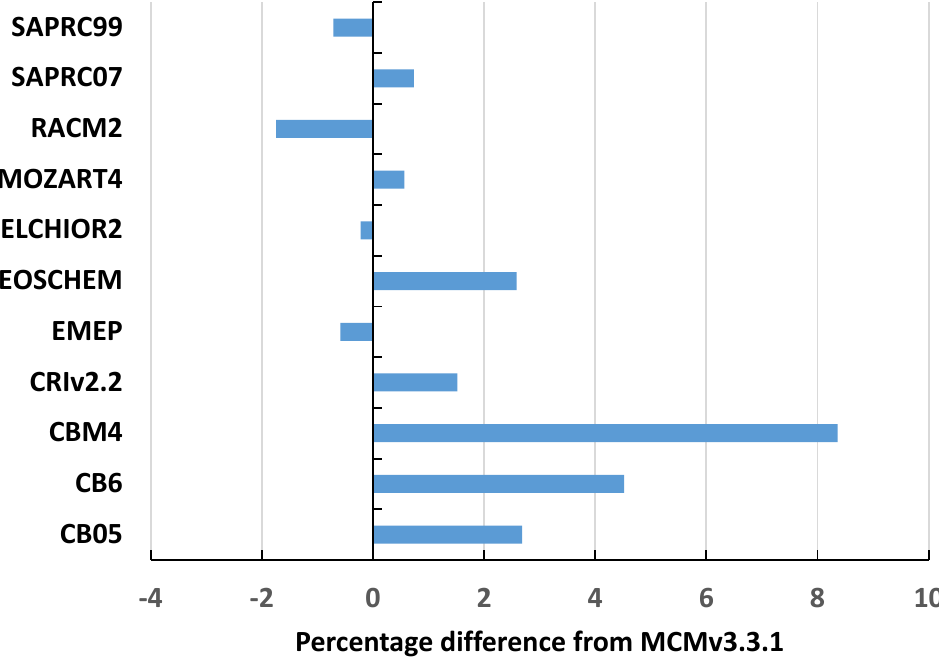
Figure 2. Average percentage di ff erences from the MCMv3.3.1 in the five-day mean hydroxyl radical number densities across the 108 sets of background conditions.